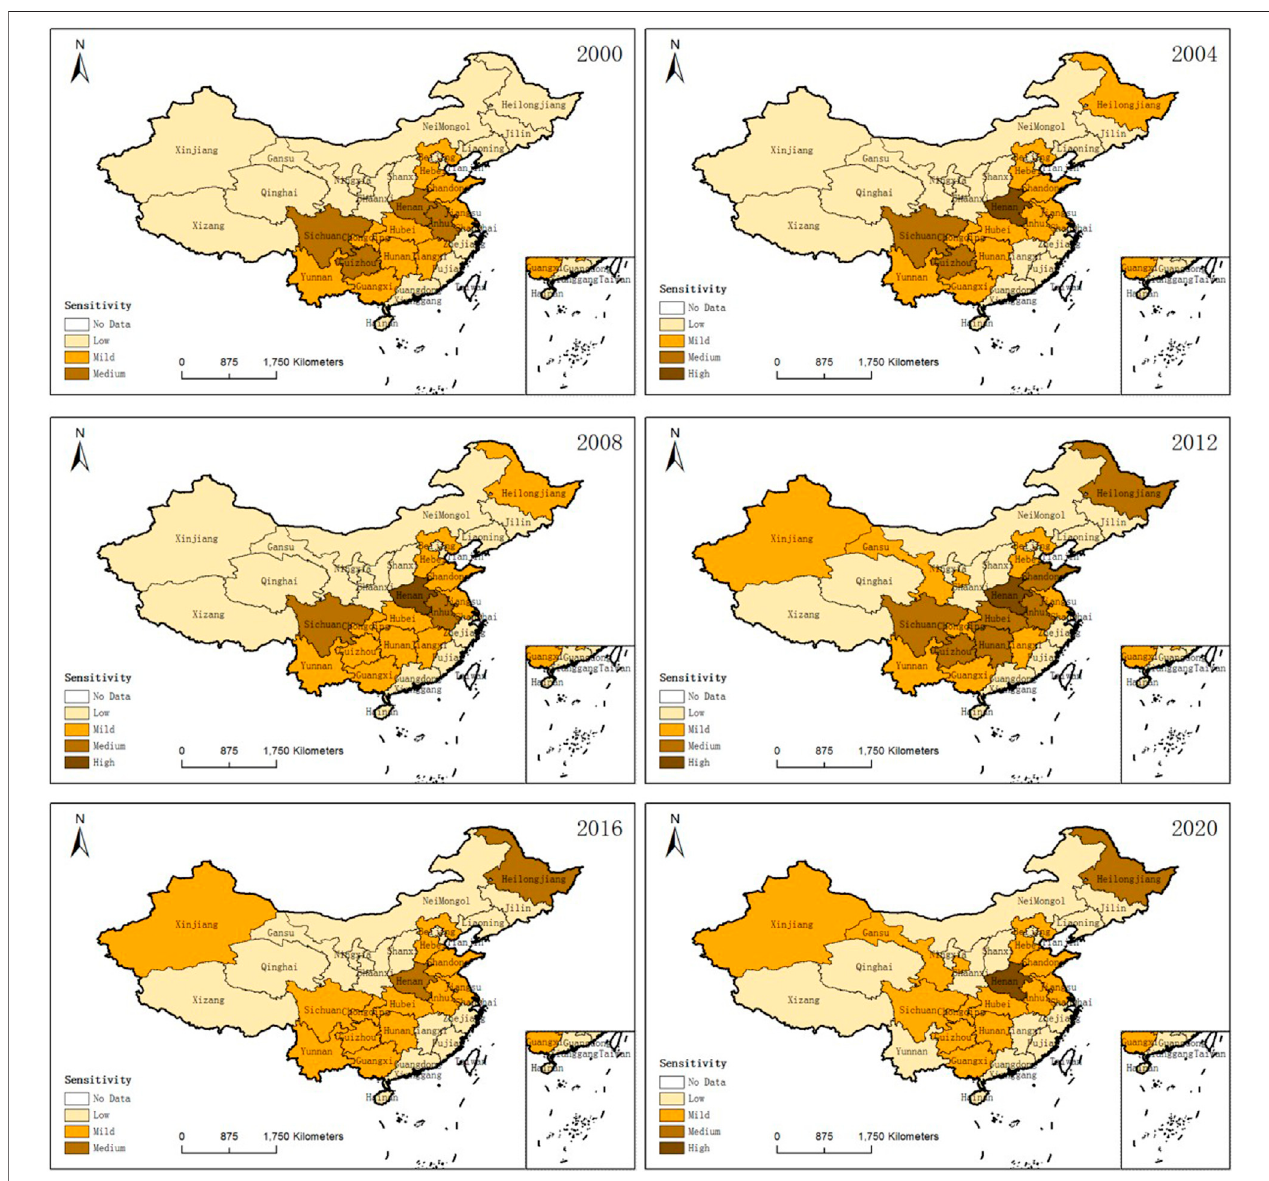
FIGURE 3 | Temporal and spatial variation of agricultural fl ood sensitivity in